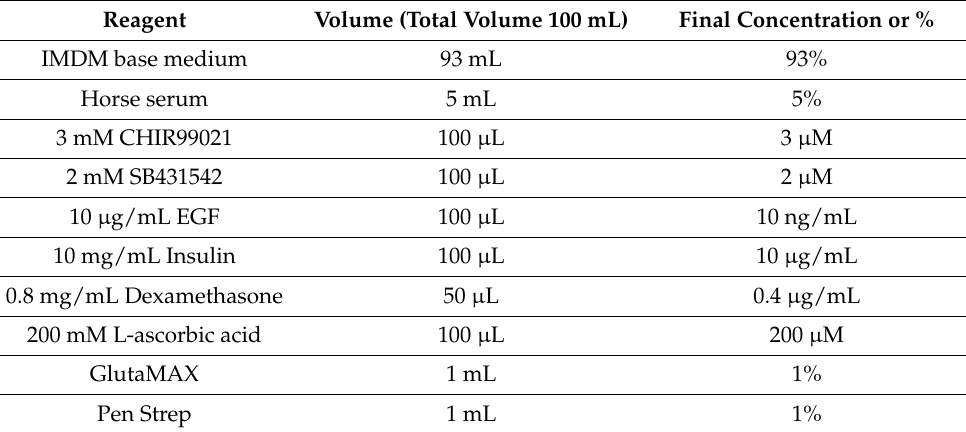
Table 3. Reagents needed to make 100 mL of